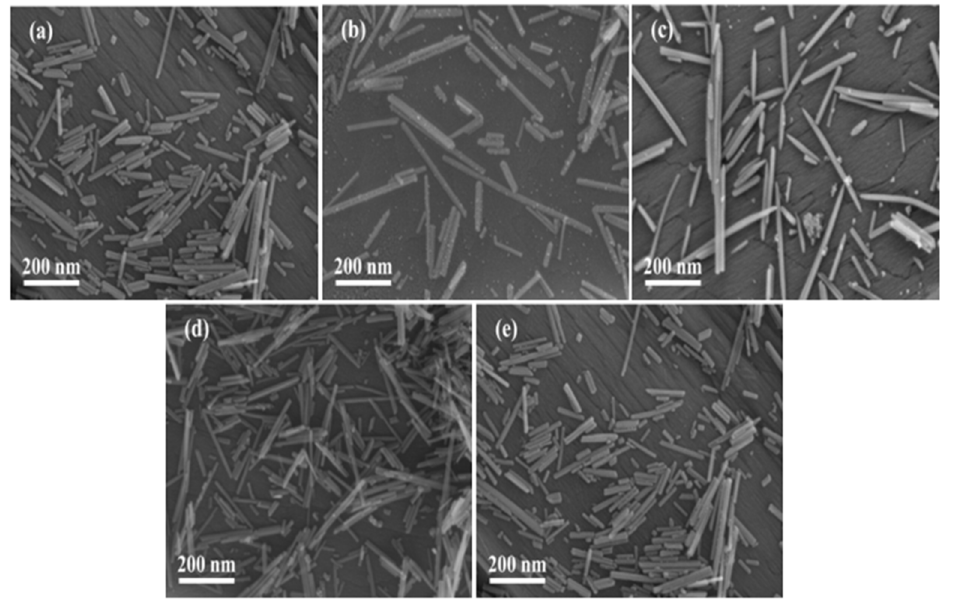
Figure 3. SEM images of ( a ) α -MnO 2 , ( b ) 0.93Pt/ α -MnO 2 , ( c ) 0.91Pt-0.5rGO/ α -MnO 2 , ( d ) 0.94Pt- 1.0rGO/ α -MnO 2 , and ( e ) 0.92Pt-2.0rGO/ α -MnO 2 .